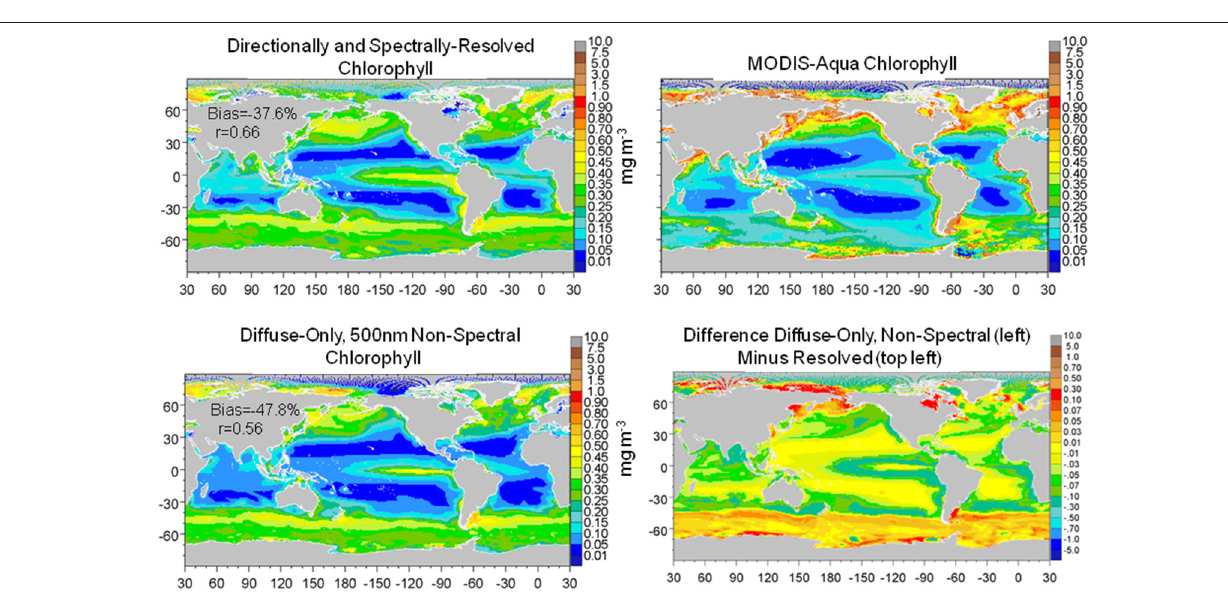
does not consider irradiance directionality but is given the correct total surface irradiance would be susceptible to the scenario described